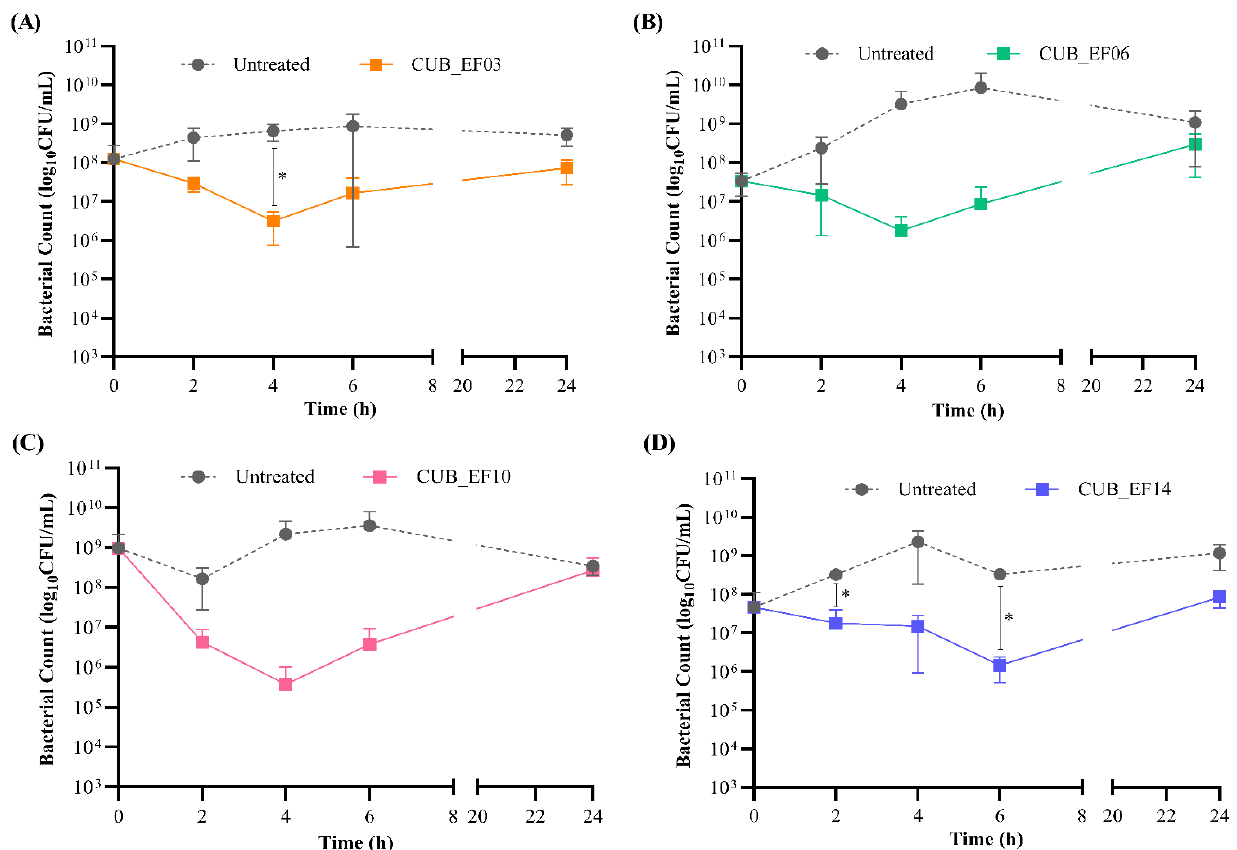
Figure 3. Time-killing curve of E. faecalis biofilms from host strains ( A ) EF 03, ( B ) EF 06, ( C ) EF 10, and ( D ) EF 14 treated with the respective phage (10 8 PFU/mL) and untreated monitored at 2 h intervals for the first 6 h and after 24 h. Data are expressed as mean ± SD. Results were statistically analyzed using a multiple t test analysis integrated in GraphPad Prism 6; p -values < 0.05 were considered significant (*).